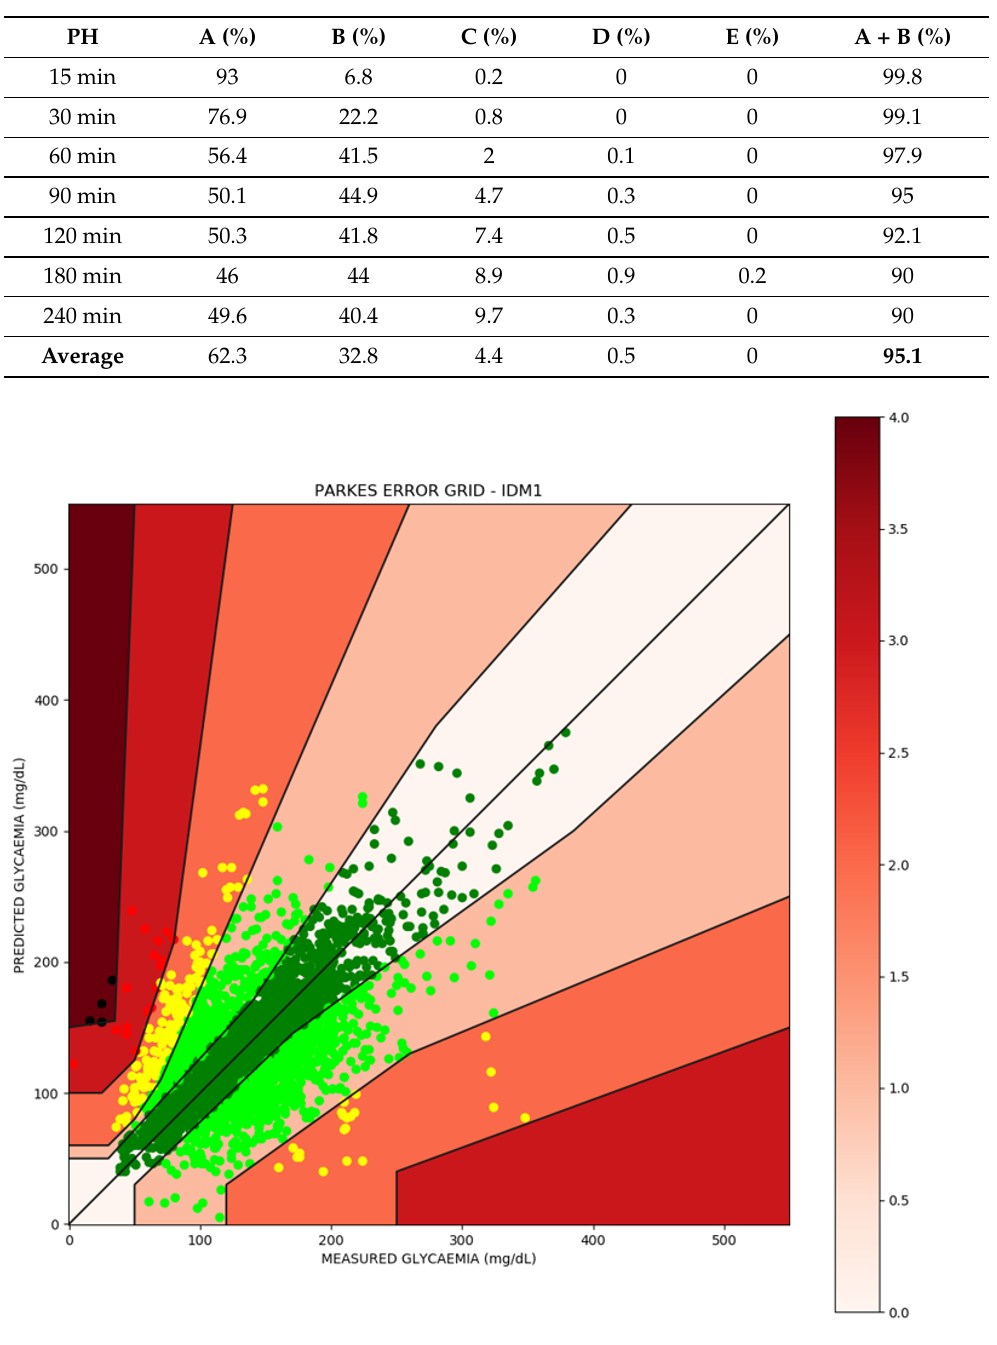
Table 7. Results of PEG for Tesseratus (3804 predictions plotted)—daytime period.